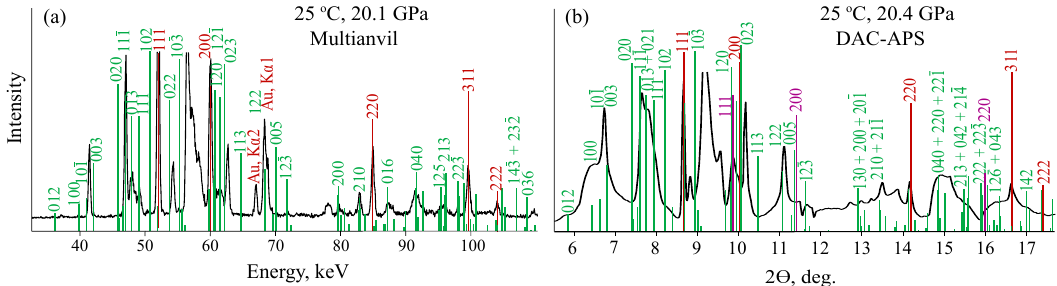
Figure 7. Indexing of diffraction patterns of α -K 2 CO 3 -IV from MA ( a ) and DAC-APS ( b ) experiments with K 2 CO 3 - P 2 1 / m structure. The peaks of K 2 CO 3 - P 2 1 / m are shown in green, peaks of Au pressure marker-in red and that of Ne-in